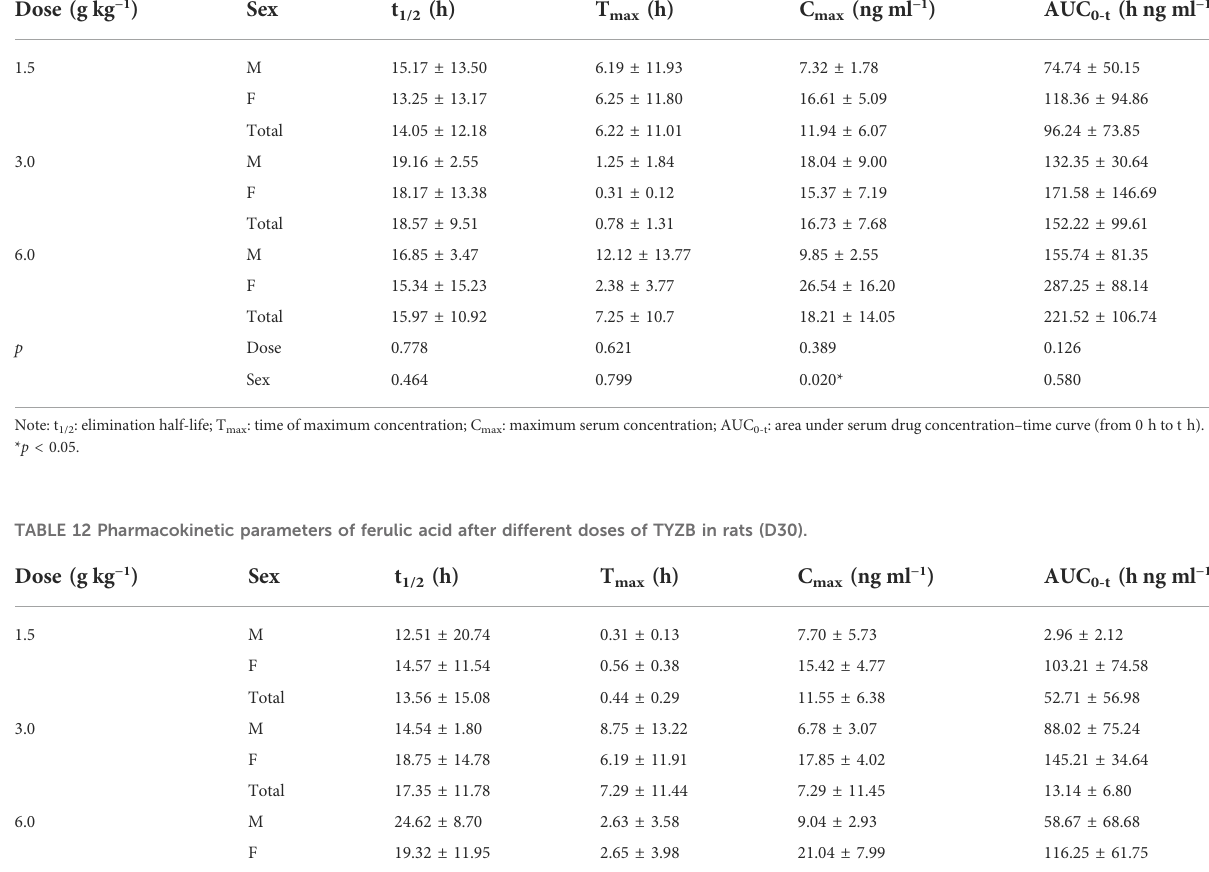
TABLE 11 Pharmacokinetic parameters of ferulic acid after different doses of TYZB in rats (D15). Dose (g kg − 1 ) Sex t 1/2 (h)